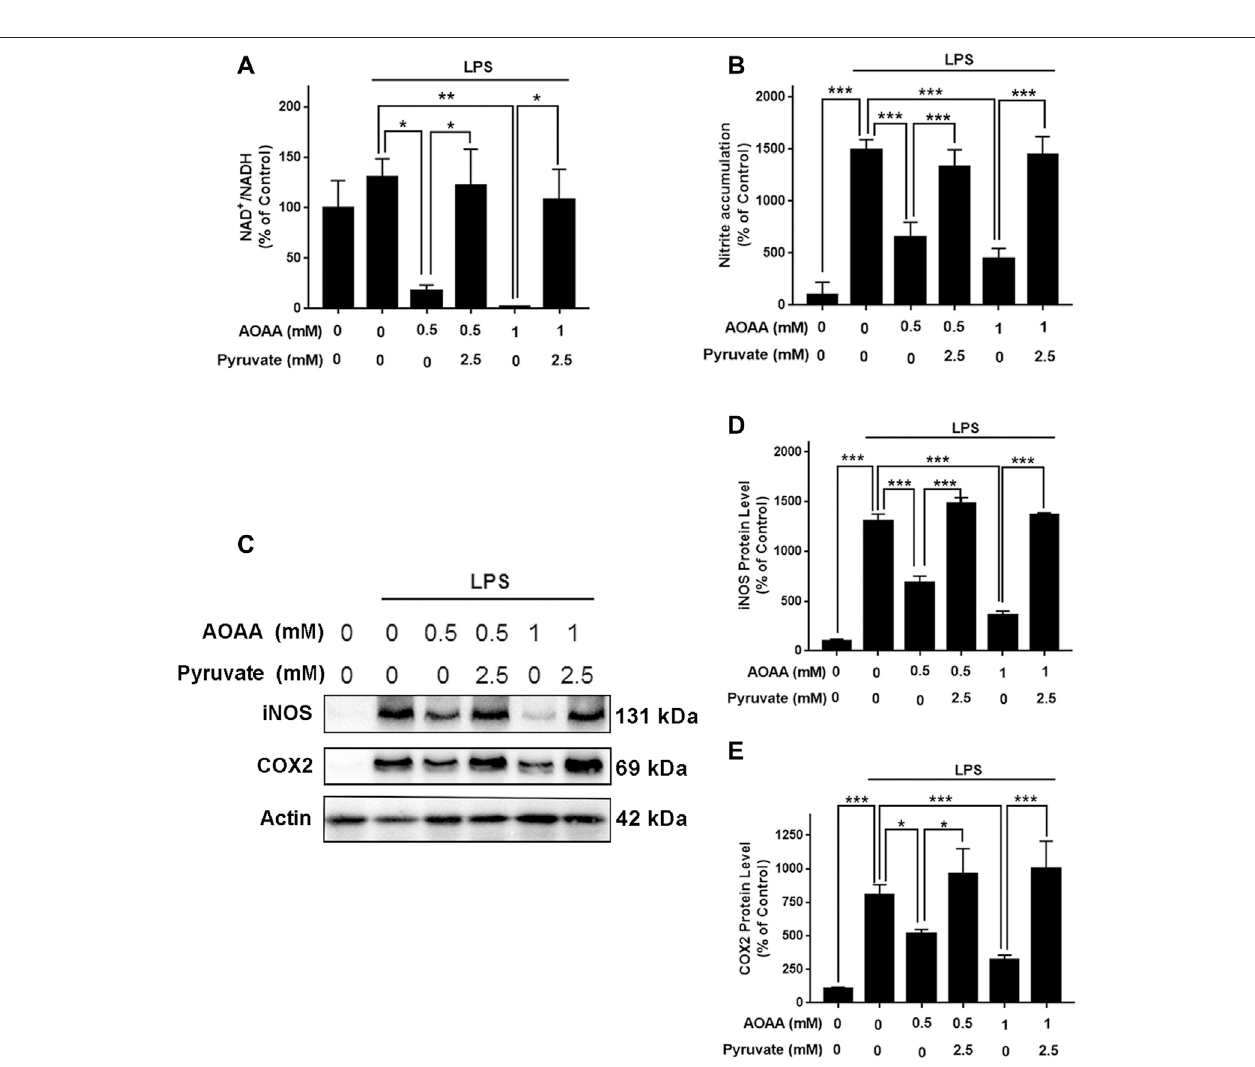
FIGURE 4 | Pyruvate treatment reversed the effects of AOAA on the cytosolic NAD + /NADH ratio and microglial activation of LPS-treated BV2 microglia. (A) Treatmentofthecellswith2.5 mM pyruvatecompletely reversedtheAOAA-produceddecrease inthecytosolicNAD + /NADHratiooftheLPS-treatedBV2microglia. (B) Pyruvate virtually abolished the AOAA-produced inhibition of the LPS-induced increases in the intracellular NO levels of the cells. (C) Western blot assays showed that pyruvate attenuated the AOAA-produced inhibition of the LPS-induced increases in the protein levels of iNOS and COX2 in the cells. (D) Quanti fi cations of the Western blot assays showed that pyruvate signi fi cantly attenuated the AOAA-produced inhibition of the LPS-induced increases in the protein levels of iNOS in the microglial cell cultures. (E) Quanti fi cations of the Western blot assays showed that pyruvate signi fi cantly attenuated the AOAA-produced inhibition of the LPS-induced increases in the protein levels of COX2 in the microglial cell cultures. After pre-treatment with 0.5 or 1 mM AOAA for 30 min, the BV2 cells were incubated with 2.5 mM pyruvate and 1 µg/ml LPS for 20 h (for NAD + /NADH assay) or 23.5 h (for NO, iNOS, and COX2 assays). N (cid:2) 3. The data were collected from three independent experiments. *, p < 0.05, **, p < 0.01; ***, p <